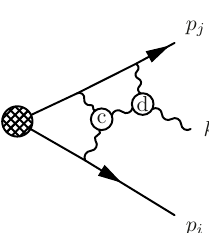
Figure 5 . An example of a non-vanishing soft two-loop contribution. In order for the soft scale k to be present in both loop momenta, the loops must be attached via purely-soft interactions to the emitted graviton, so c, d ≥ 2 . Any soft loop yields an additional λ 2 suppression, and the two-loop contribution therefore starts at sub-subleading order λ 4